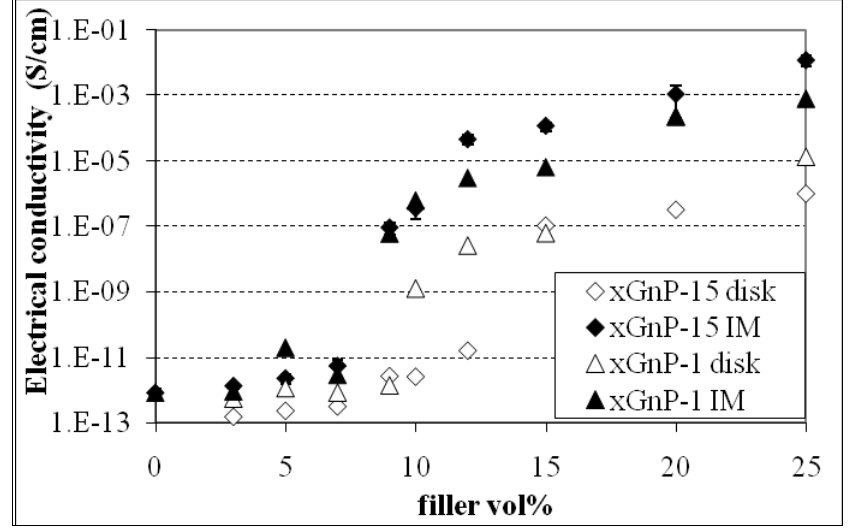
Figure 6. Effect of filler anisotropy on the percolation threshold and conductivity of x GnP-PP nanocomposites.